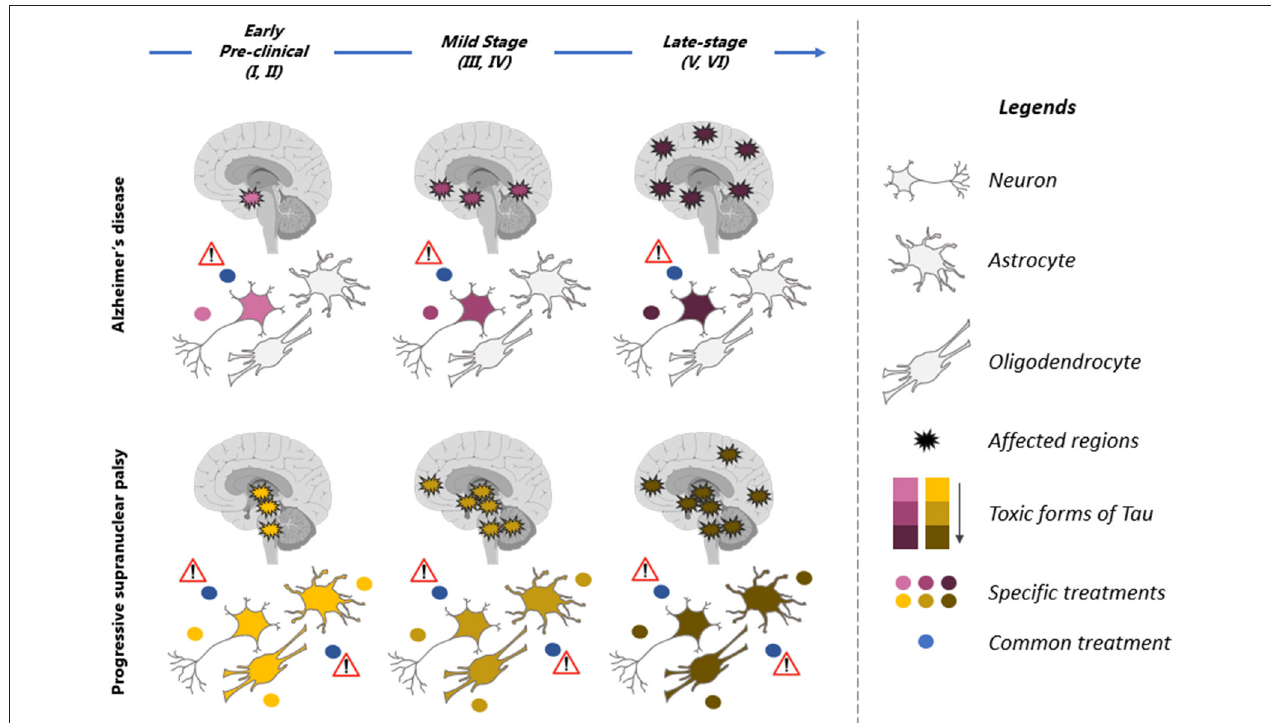
FIGURE 2 | Therapeutic strategies for prevention of tau pathology in tauopathies. Illustration of the spatiotemporal pattern of the propagation of tau pathology in Alzheimer’s disease (AD) and Progressive supranuclear palsy (PSP). Six stages (I–VI) of tau pathology can be observed in both diseases (top blue arrow). The affected regions in the brain are indicated by spiky circles. Tau pathology begins in distinct regions in each of these tauopathies and propagates differently. Tau pathology is predominant in neurons in AD brain while neurons and glial cells are affected in PSP. Different toxic forms of tau are observed during the course of the disease. They present a low toxicity (pink in AD and yellow in PSP) at early stages of the disease and high toxicity (dark red in AD and brown in PSP) at late stages of the disease. These forms are distinct in AD (yellow to brown) and PSP (pink to dark red). A therapeutic molecule should be designed for each toxic form of tau (yellow, brown, pink, and dark red dots). The therapeutic strategy should also be adapted to the stages of disease as tau forms vary during the course of the disease. Because the toxic forms of tau differs in AD and PSP, a molecule not specific to these forms (blue dot, common treatment) might be inefficient and even detrimental to patients by affecting forms of tau that are not